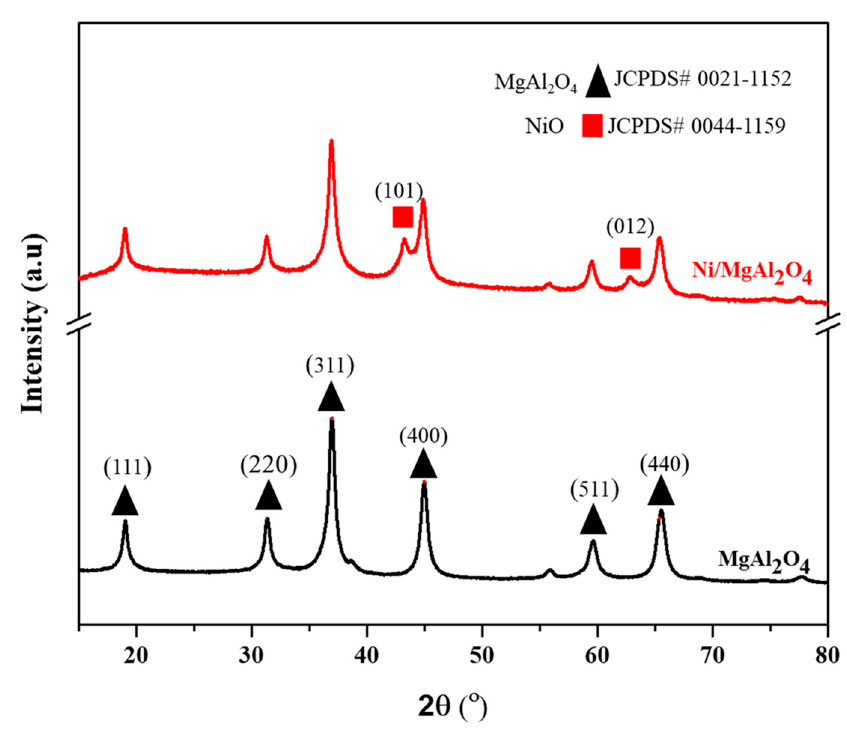
Figure 3. XRD pattern of synthesized MgAl 2 O 4 and Ni/MgAl 2 O 4.